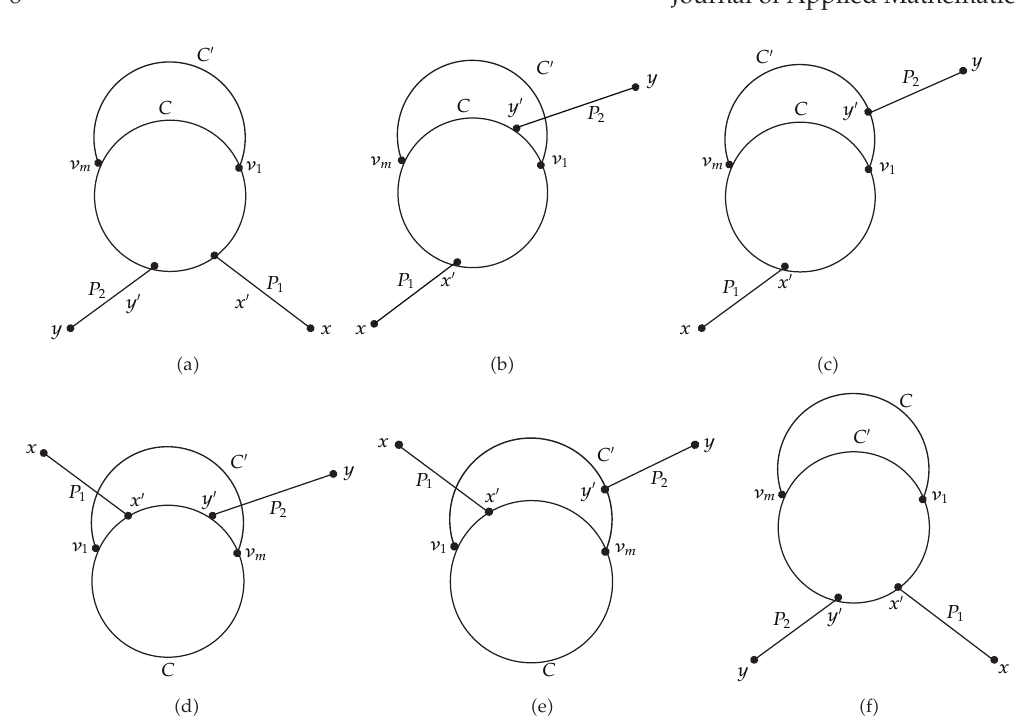
Figure 3: Illustration for Subcases 1 . 2 . 2 and 2.2 of Lemma